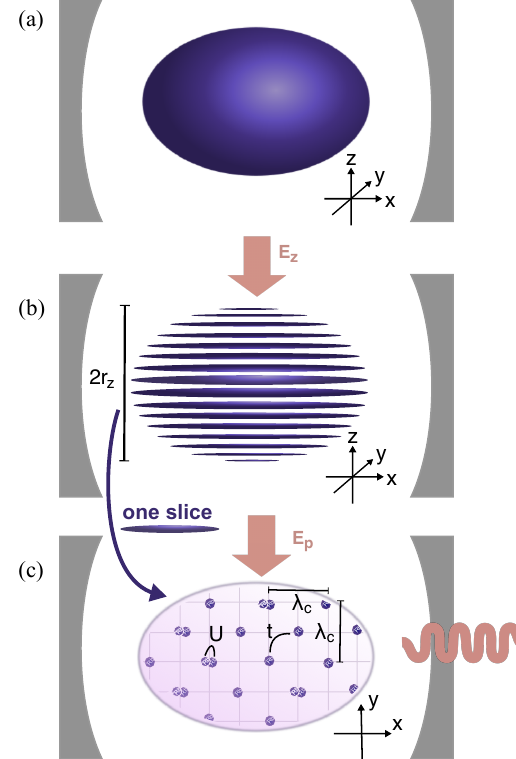
Figure 1: Sketch of the experimental system. The atoms are first prepared as (a) a three-dimensional BEC, and then cut into (b) two-dimensional slices by an external laser pump along z direction. (c) Due to the pumping laser along y direction and the interplay with the cavity, they finally self-organize into a checkerboard lattice with wavelength λ along both x and y directions. The onset of the self-organization c can be detected by the intracavity photons. After the checkerboard lattice is formed, the system can be mapped to a Bose-Hubbard model with tunneling strength t and on-site interaction U